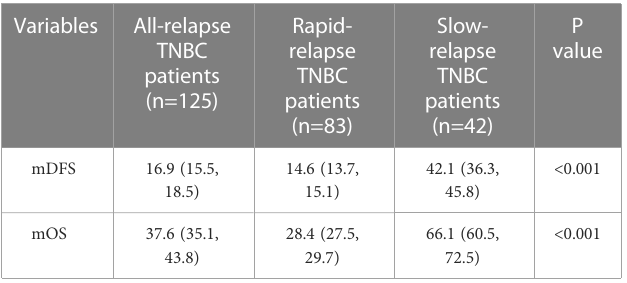
mDFS, Median Disease Free Survival. DFS, The time from diagnosis of breast cancer to the fi rst